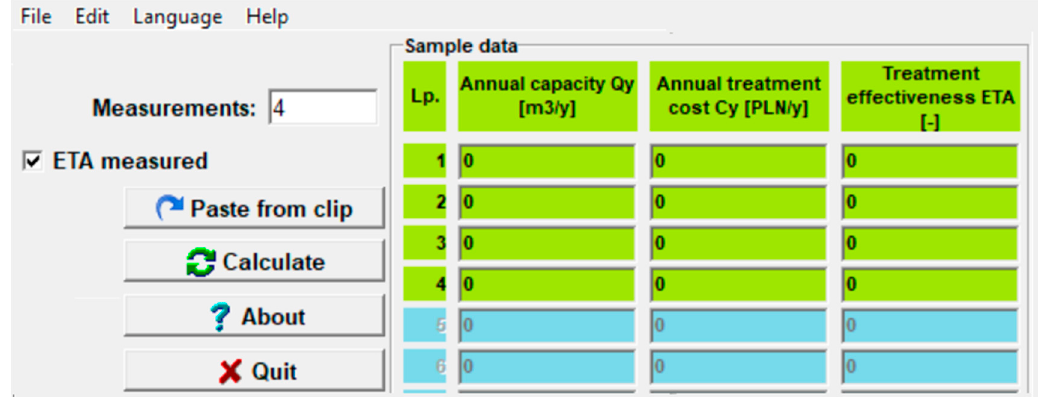
Figure 4. Computer program: “Modelling of wastewater treatment costs”.